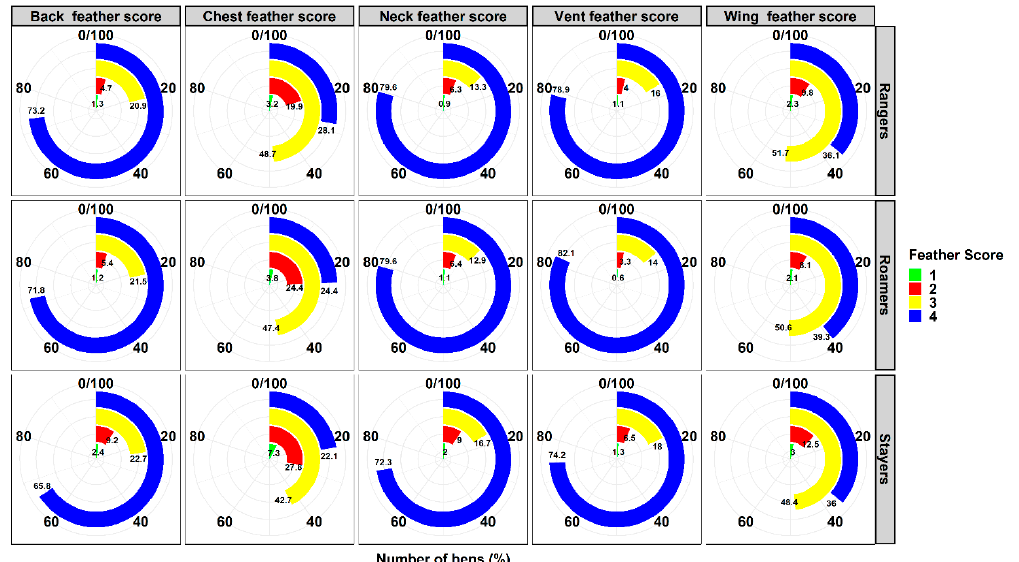
Figure 3. Descriptive prevalence of plumage condition observed in 5290 commercial laying hens that were classified as stayers, roamers and rangers. The figure summarises the various ranging groups pooled from 5 flocks. A score of 4 indicates full feather cover, 3 indicates moderate feather cover, 2 indicates feather loss with more than 50 % of the skin covered with feather, and 1 indicates severe feather loss with less than 50 % of the skin covered with feather [23].